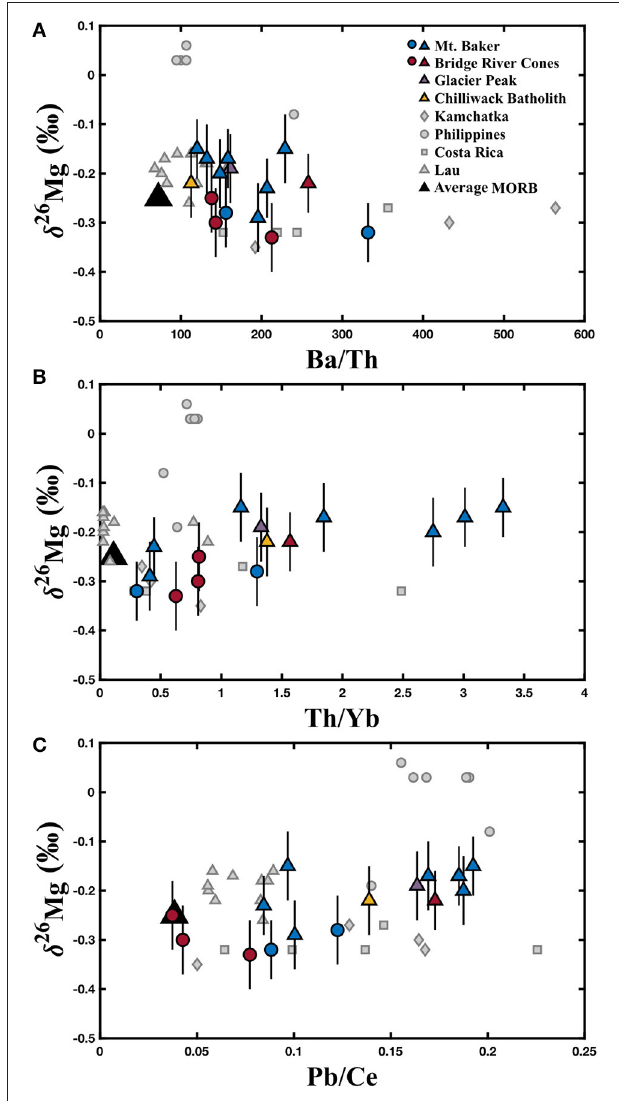
FIGURE 5 | Variation of δ 26 Mg with, Ba/Th (A) , Th/Yb (B) , and Pb/Ce (C) . The black triangles represent the average MORB composition. MORB δ 26 Mg value ( − 0.25 ± 0.07 ‰ ) is from Teng et al. (2010a), while Th/Yb (0.1113), Pb/Ce (0.0384), and Ba/Th (72.2772) are from Gale et al. (2013). The colored circles represent those samples identified as most primitive from Mt. Baker and the Bridge River Cones, while the colored triangles represent samples that exhibit crustal contamination. Literature data are represented by gray symbols and are from Li et al. (2017). North Cascades data are reported in Table 1 . Error bars represent the 2 SD for each North Cascades